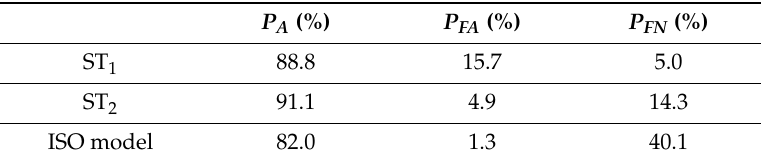
Table 2. The lane-change decision